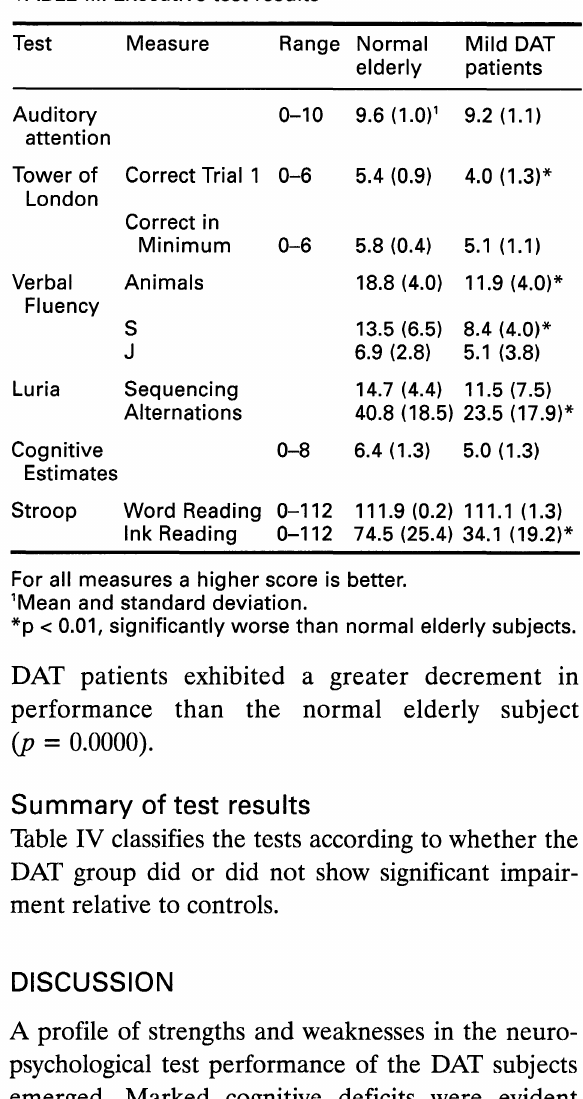
TABLE III. Executive test results